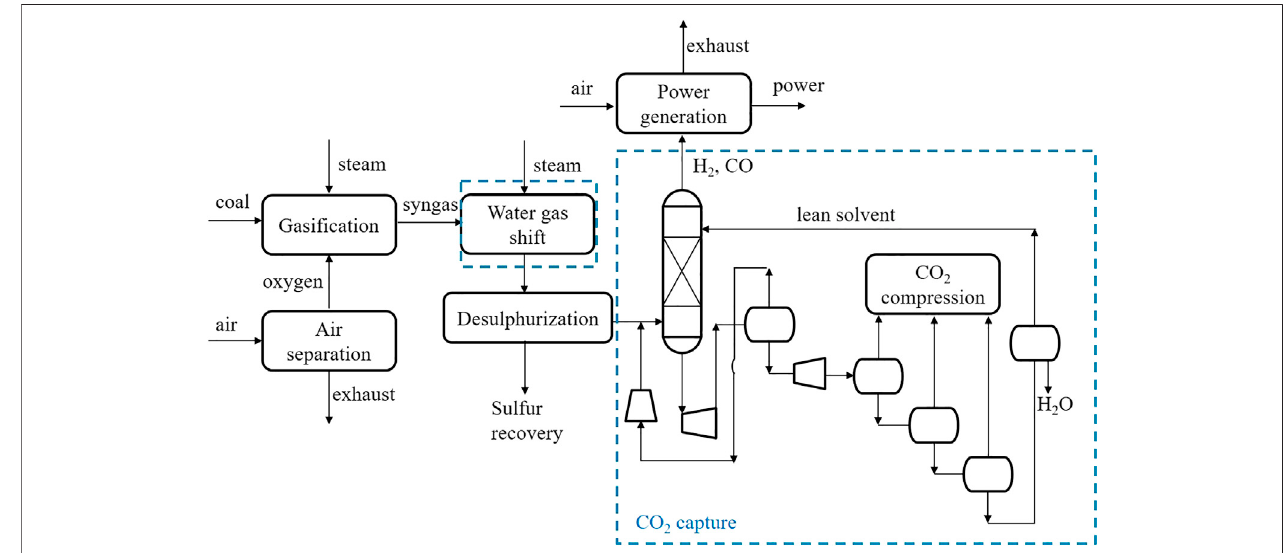
FIGURE 1 | Process fl ow diagram of pre-combustion CO 2 capture.